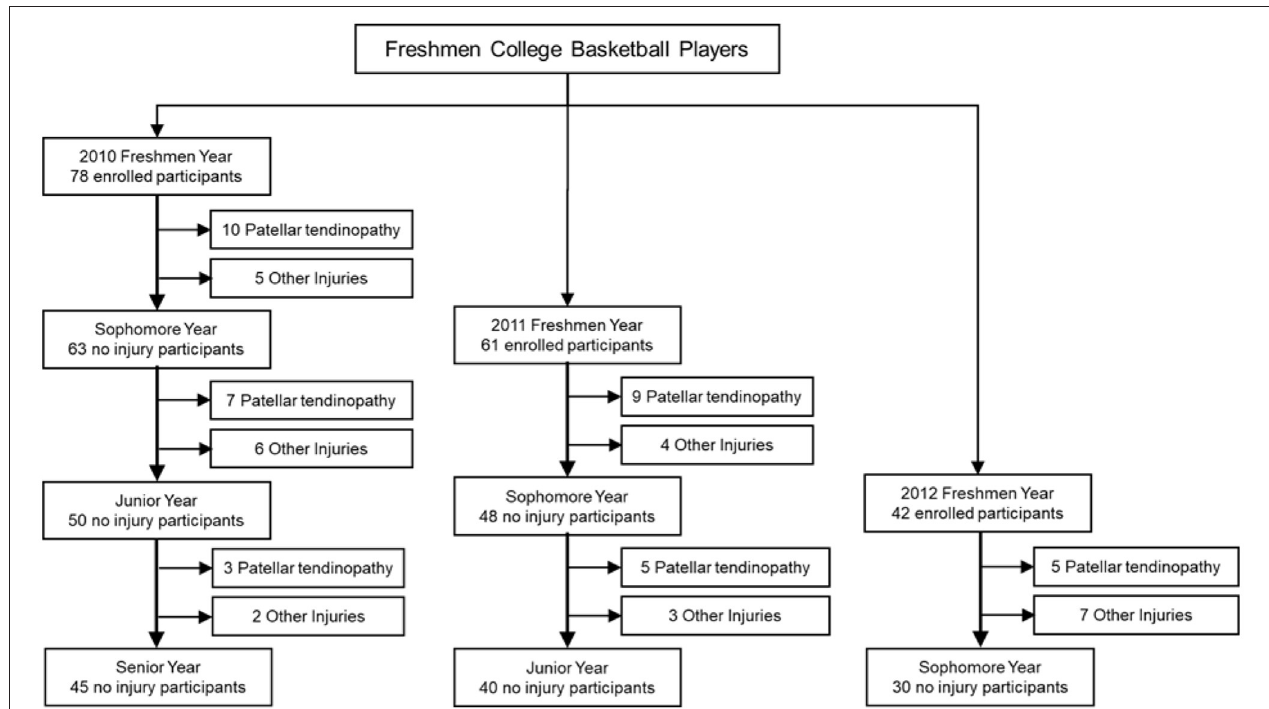
FIGURE 1 | Enrollment of